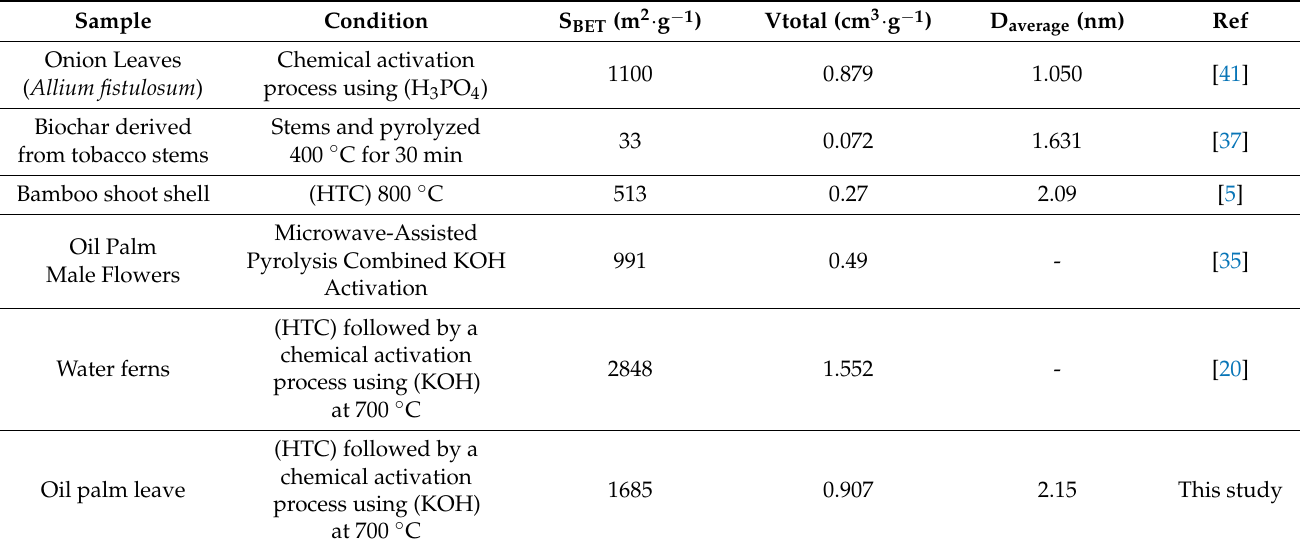
Table 3. Production of activated carbon by different manufacturing processes and under different